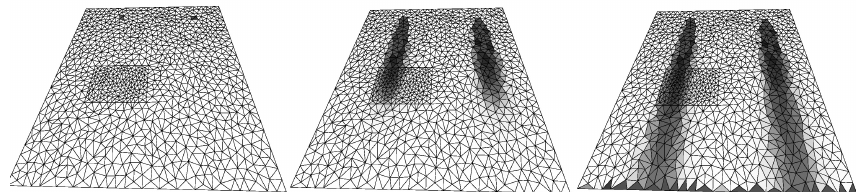
Fig. 5. Water flow from two sources on triangulated irregular mesh describing an inclined plane. The three images show the soil moisture (white = dry, black = wet) at the beginning and after 30 and 60 time steps,